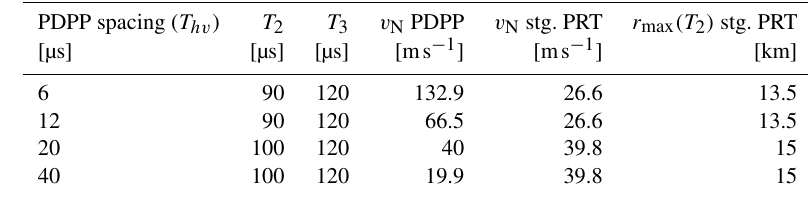
0 to 46 0 to 45 45 to 90 0 to 40